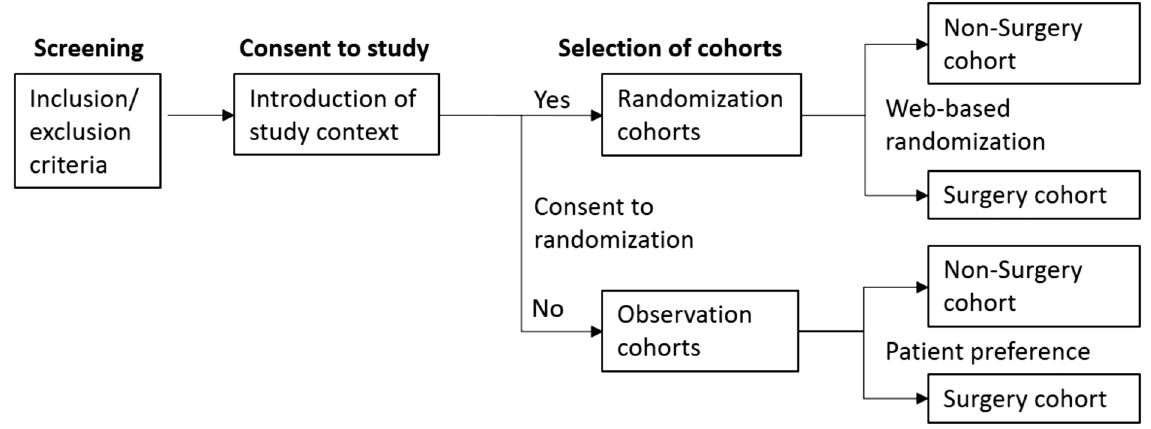
Figure 1. Comprehensive cohort study design. An enrollment of participants consists of three steps: screening, consent for study and selection of cohorts. A web-based system was used across participating hospitals for